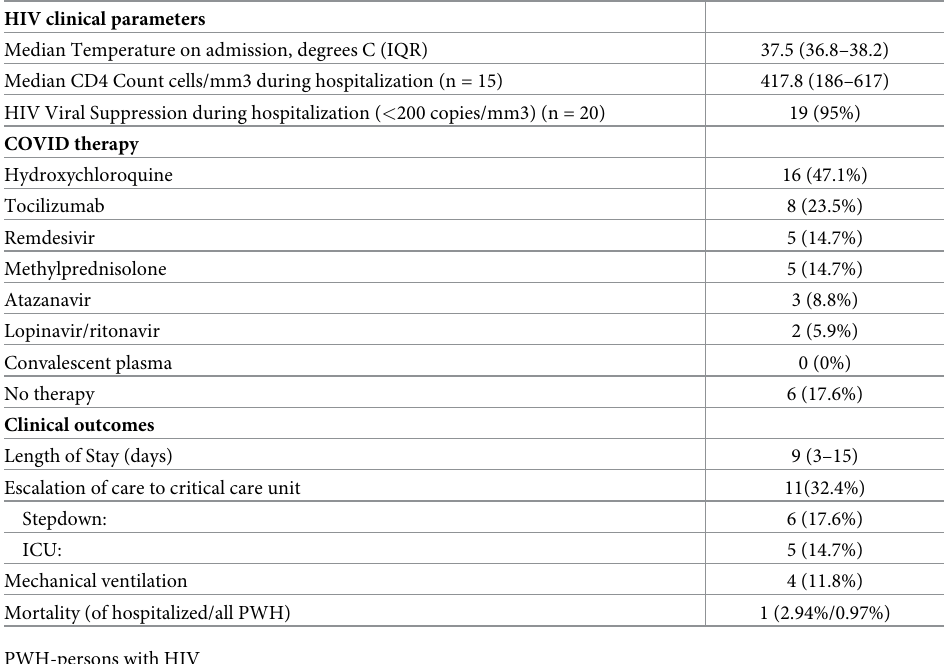
Table 2. Characteristics of hospitalized patients. HIV clinical